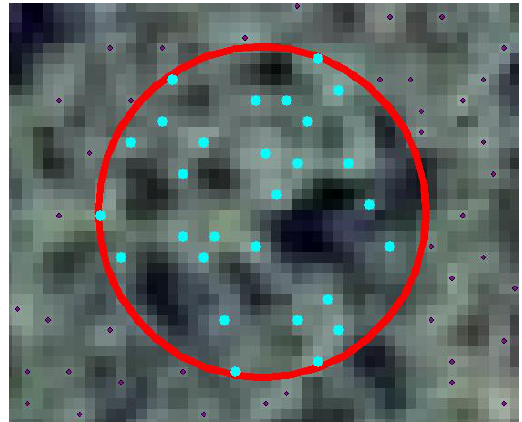
Figure 7. The evaluation procedure. Plot ID 8 and results from the red band. 28 tree tops have been counted, while according to reference data, trees are 25.